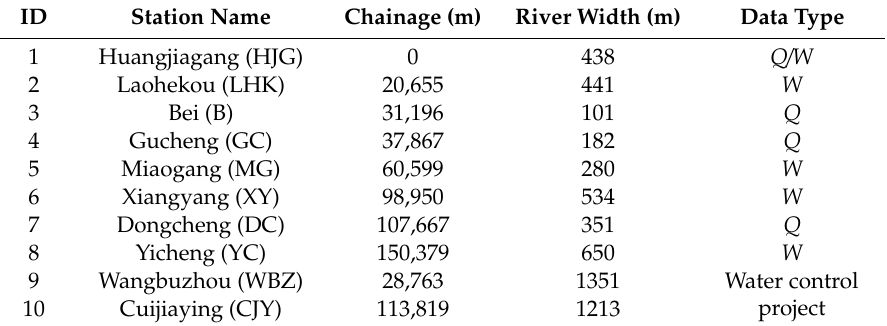
Table 1. Summary of the hydrometric stations. Q denotes discharge; W denotes water level.